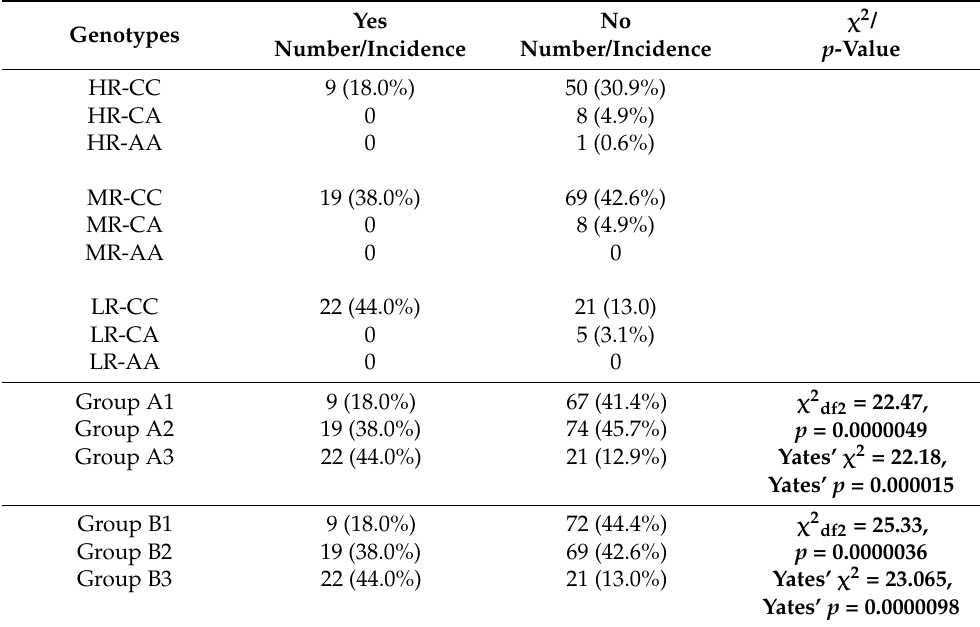
Table 5. Examination of the interaction between HPSE rs4693608 and rs4364254 SNPs and HPSE2 rs657422 SNP in correlation with primary extramedullary disease (EMD) of multiple